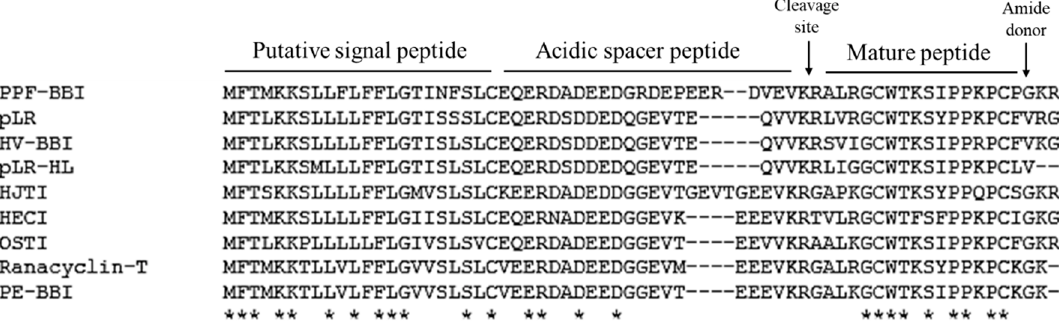
Figure 1. Multiple sequence alignment test results from Clustal Omega. Fully conserved residue indicated by asterisks.